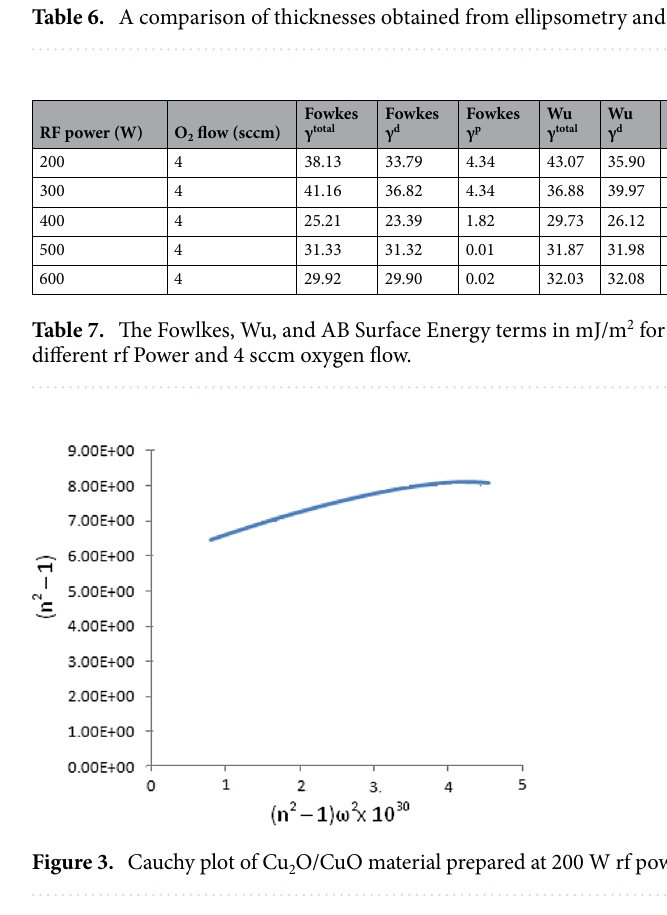
Fig. 3 for the film prepared at 200 W rf power to evaluate the function oscillator strength C UV and frequency ω UV in the ultraviolet region . The function oscillator strength in the infrared region was evaluated from Eq. 19 using C UV and the static permittivity from Eq. 18.The Tarbo–Winterton (T–W) approximation evaluation was performed with v e = 3 × 10 15 s -1 and T = 298 K in Eq. 21 from the Ellipsometry results to obtain the Hamaker con- stant for Cu 2 O/CuO|Water|/Cu 2 O/CuO and Cu 2 O/CuO|Air|/Cu 2 O/CuO structure for film materials prepared at different deposition rf power. The surface energy (dispersive component of Fowkes contribution) results were